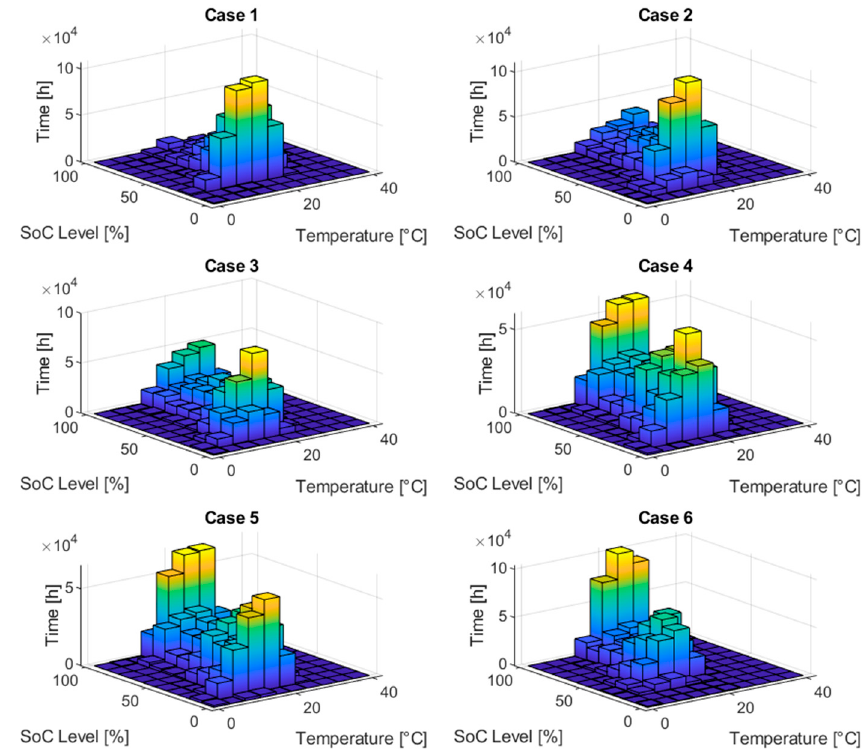
Figure 12. 3D histogram of the simulated 6 cases showing the time ES spent on each temperature and SoC state.